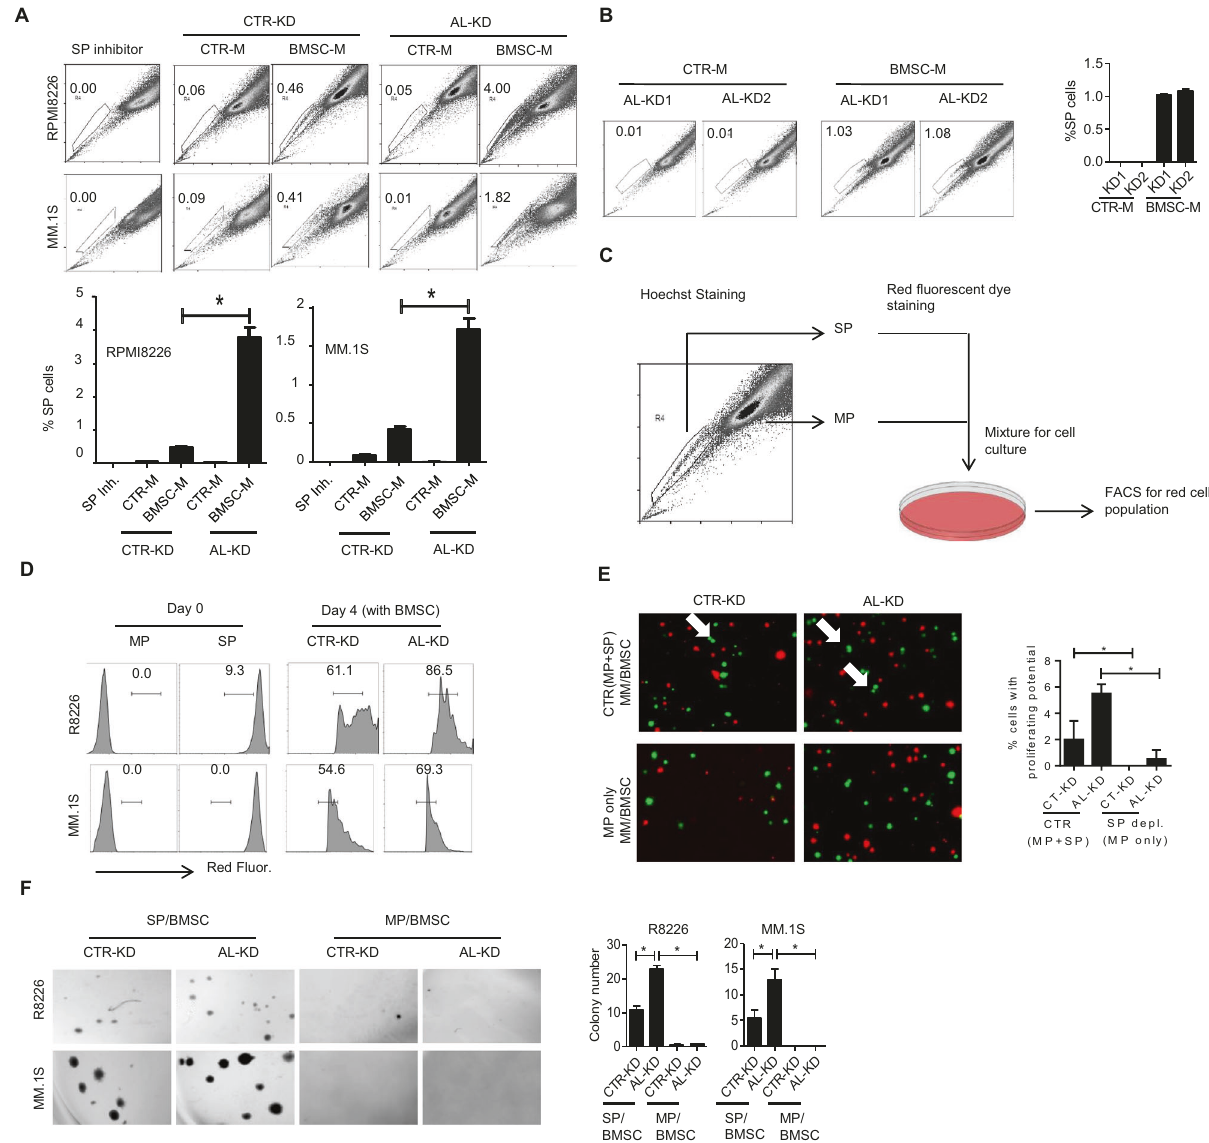
Fig. 1 Bone marrow stroma-derived soluble factors promote ALCAM-knockdown myeloma cell side population. A Hoechst staining of CTR-KD or AL-KD MM cells (RPMI8226 or MM.1S) cultured in regular medium (CTR-M) or BMSC-conditioned medium (BMSC-M) for 48 h. The numbers indicate the percentage of SP cells. B Hoechst staining of AL-KD1 and AL-KD2 RPMI8226 cells cultured in regular medium (CTR-M) or BMSC-conditioned medium (BMSC-M) for 48 h. C Schematic graph: After cell sorting, SP cells were labeled with red fl uorescent dye, and MP cells were labeled with CFSE. The labeled SP and MP cells were re-mixed with the ratio (SP:MP = 2:98). D SP cell proliferation was examined by fl ow cytometry for red fl uorescent intensity dilution. E Fluorescence confocal microscopy of MM cells (green) and BMSCs (red) under 3D printing. F Hoechst staining of RPMI8226 cells, followed by cell sorting to isolate SP- and MP-only MM cells. The cells were used for the set of colony formation assay (left panel). Statistical results from the colony formation assays (right panel). Data are the mean of three independent experiments in three replicates. * p <